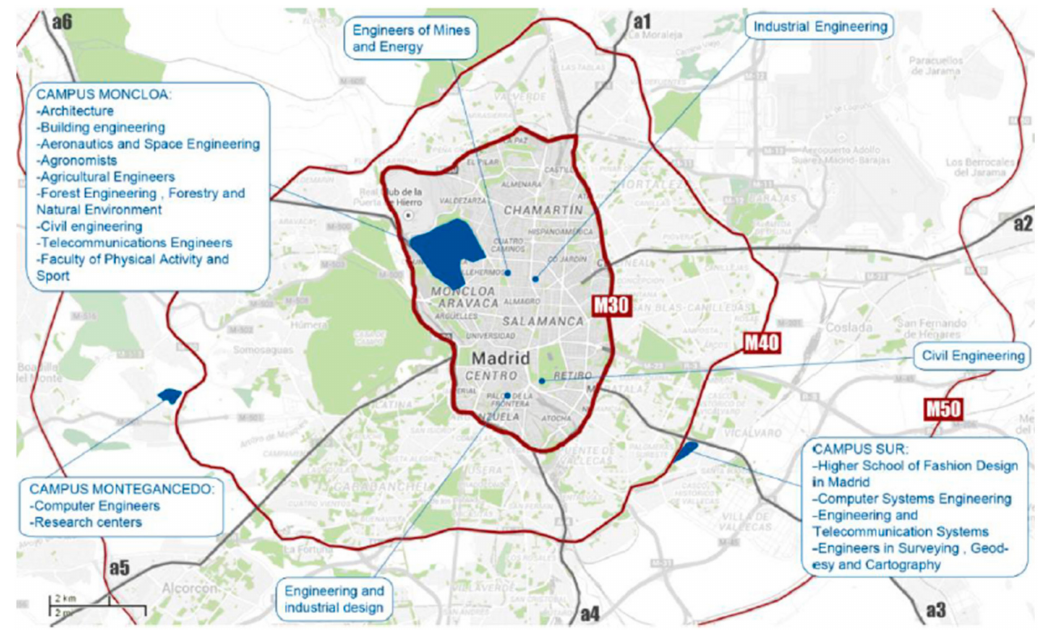
Figure 2. Location of Moncloa CEI Campus in